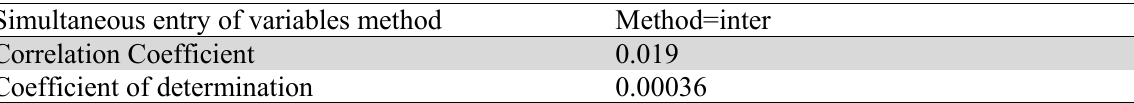
Correlation Coefficient between PEG ratio and stock returns Simultaneous entry of variables method